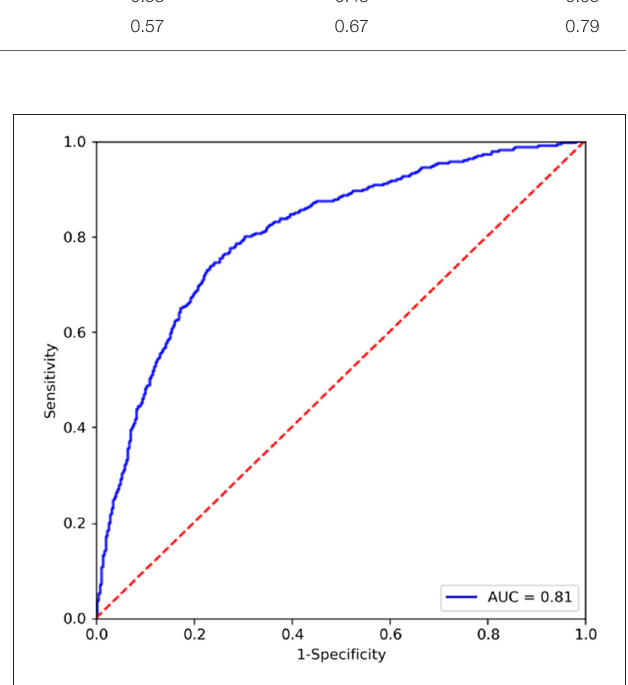
FIGURE 4 | ROC curve of Chest L-Transformer on the testing